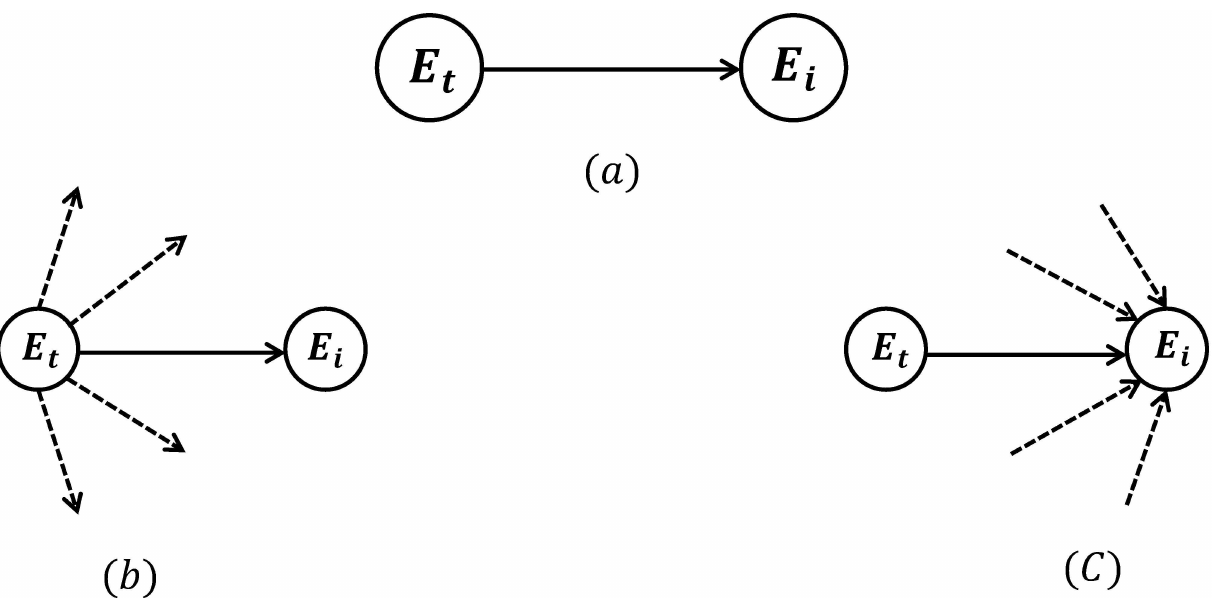
Fig 2. Following relationship. In-degree: (a): E t follows E i . (b): E t : active follower when retweeted from E i . (c): E i influential followeewhose tweet got retweetedby E t